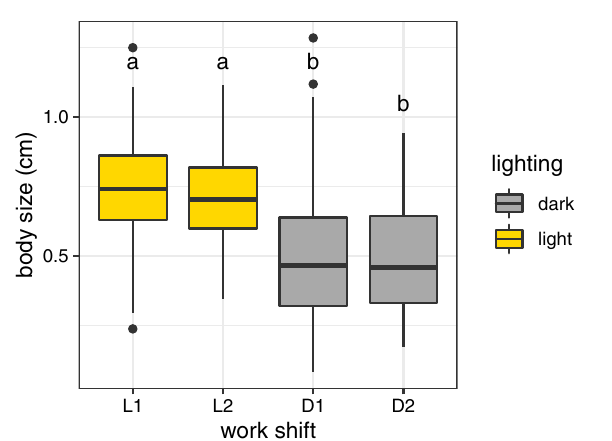
Figure 5. Boxplots showing body size (cm) distribution of ants measured in each selected work shift (ANOVA: F (3, 701) = 88.04, p < 0.001). Letters above boxplots indicate statistically different distributions in a Tukey’s post-hoc test of an